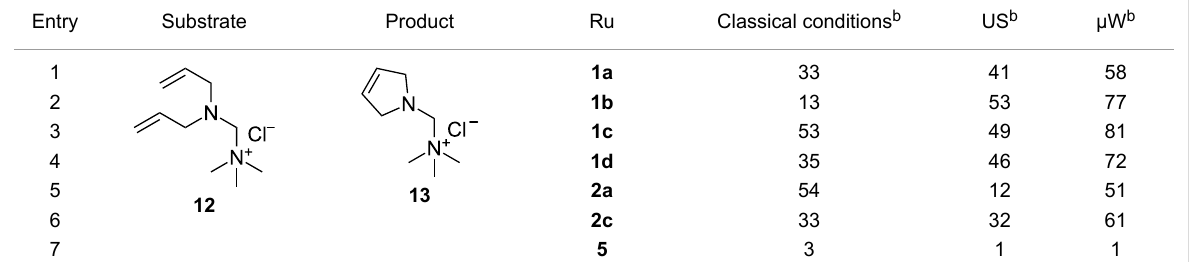
Table 2: Effect of the counter ion and substituents size of the NHC ligand in catalysts 1b – d , and 2a , c on their efficiency in the RCM of substrate 12 in water under μ W and US irradiation. a